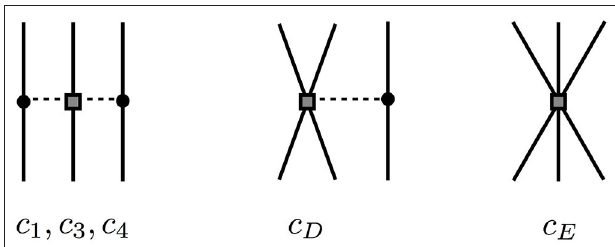
FIGURE 1 | Feynman diagrams of the chiral 3N force at N2LO, from the left to the right: 2 π -term, 1 π -term, and ct